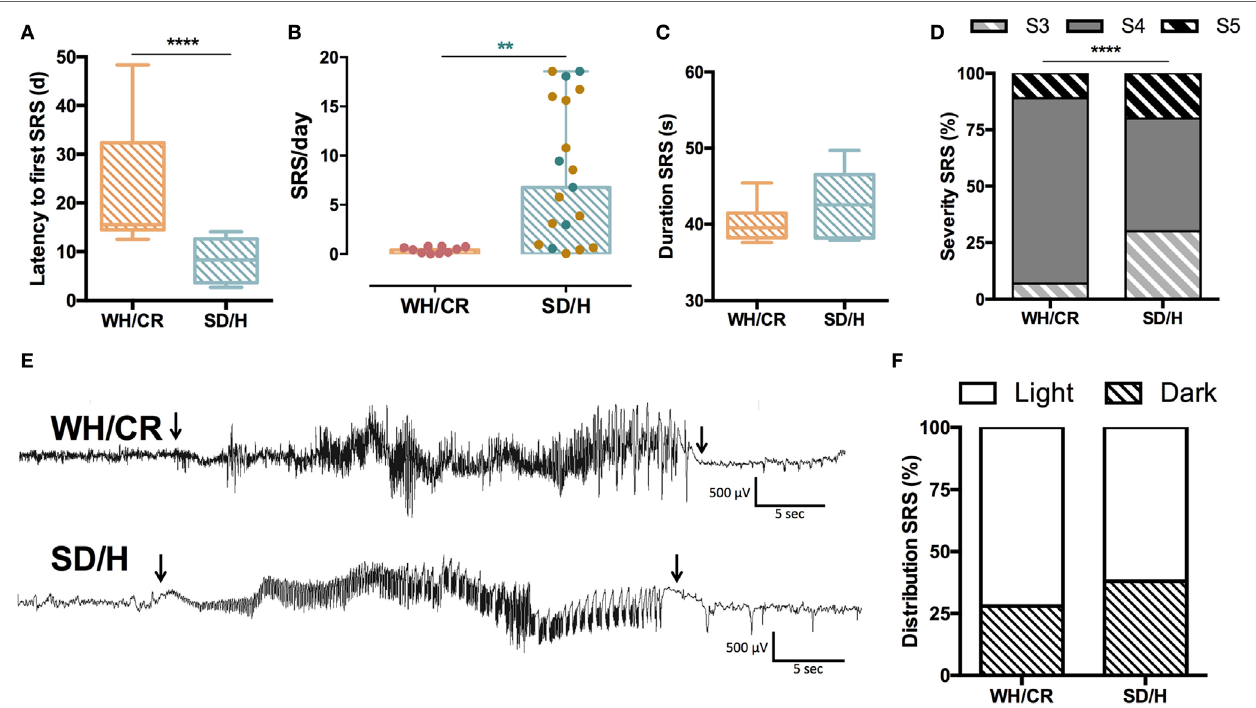
FigUre 3 | SRS characterization in kainic acid-induced SE (KASE) WH/CR and KASE SD/H rats. (a) WH/CR rats ( n = 10) showed a significant longer latency to the first SRS when compared to SD/H ( n = 8). Mann–Whitney U test. **** p < 0.0001. (B) SRS frequency during the chronic period. A significant higher number of SRS per day was demonstrated for the SD/H rats compared to the WH/CR rats 12 weeks post-status epilepticus (SE). Red and blue dots represent WH/CR and SD/H, respectively, following modified protocol; brown dots represent SD/H following Hellier protocol. Mann–Whitney U test. ** p < 0.01 after considering only animals that underwent modified SE protocol. (c) The duration of SRS was similar in both strains. (D) WH/CR and SD/H were characterized by different distribution of SRS. **** p < 0.0001. Fischer’s exact test. (e) Representative spontaneous electrographic seizure (S4) during chronic period (12 weeks post-SE) of a WH/CR and SD/H rat. Arrows indicate the onset and the end of the seizure. (F) The circadian distribution of SRS was similar in both strains with a higher frequency of SRS during the light phase. WH/CR n = 10 and SD/H n = 6 (c,D,F) . WH/CR, Wistar Han/Charles River; SD/H, Sprague-Dawley/Harlan; SRS, spontaneous recurrent seizures; d, days. Graph B is reported as mean ±